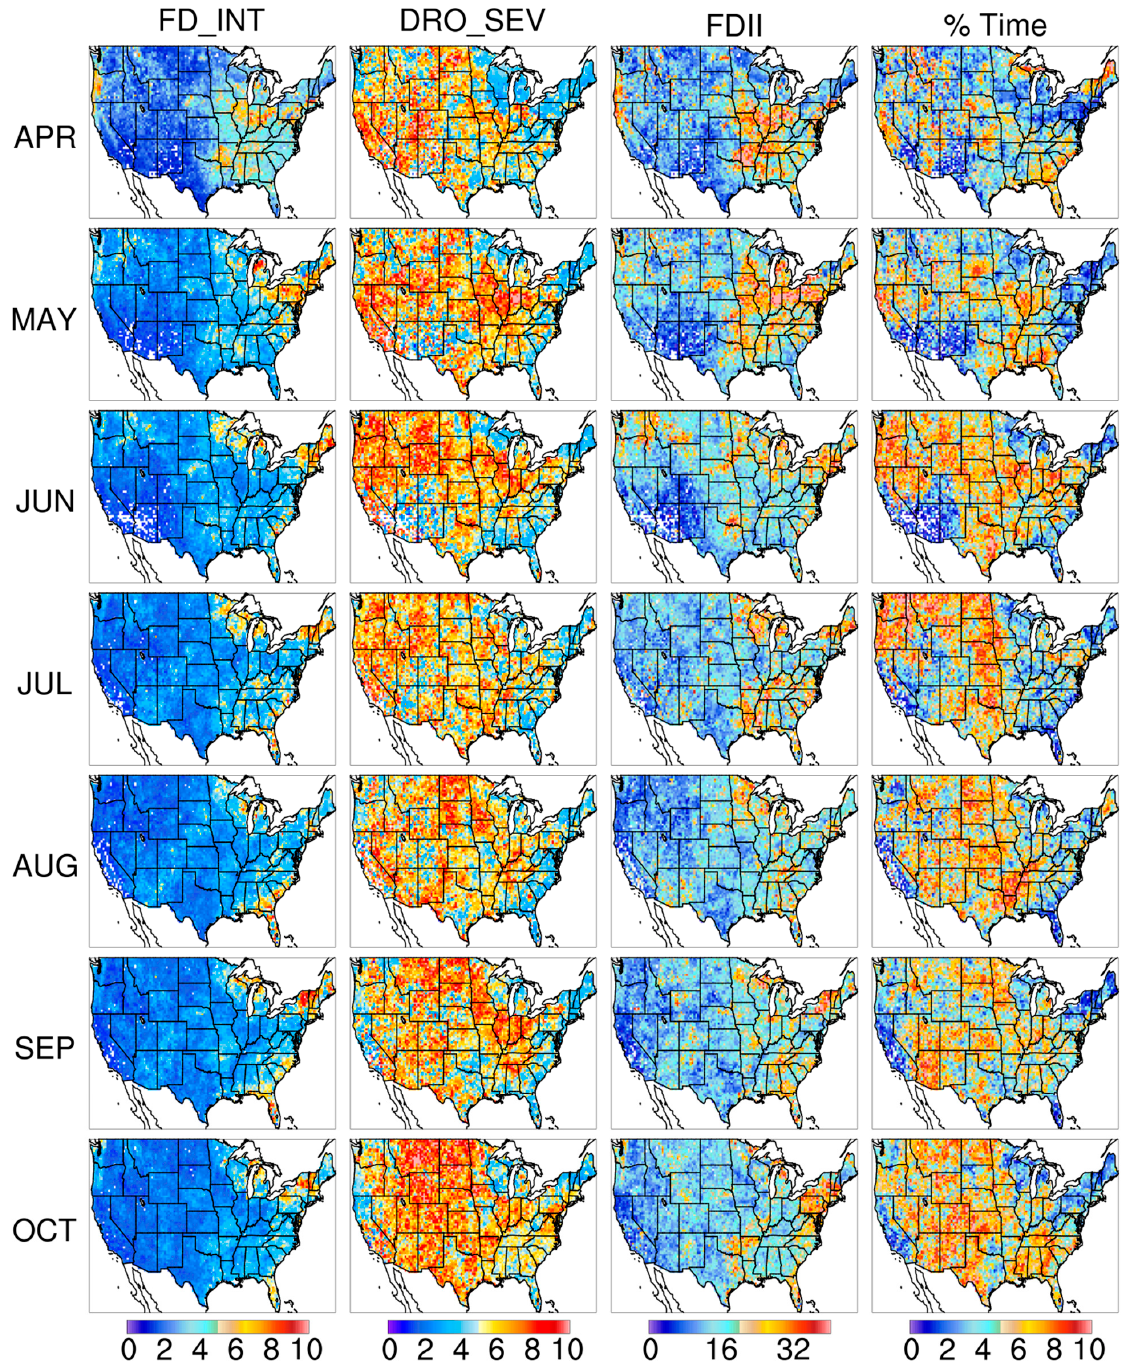
Figure 2. Monthly climatology depicting the average (left column) FD_INT, (second column) DRO_SEV, and (third column) FDII for each grid point, and the (right column) percentage of pentads characterized by flash drought during the 1979–2017 period of record. Only pentads containing flash drought were used to compute the values for each term.